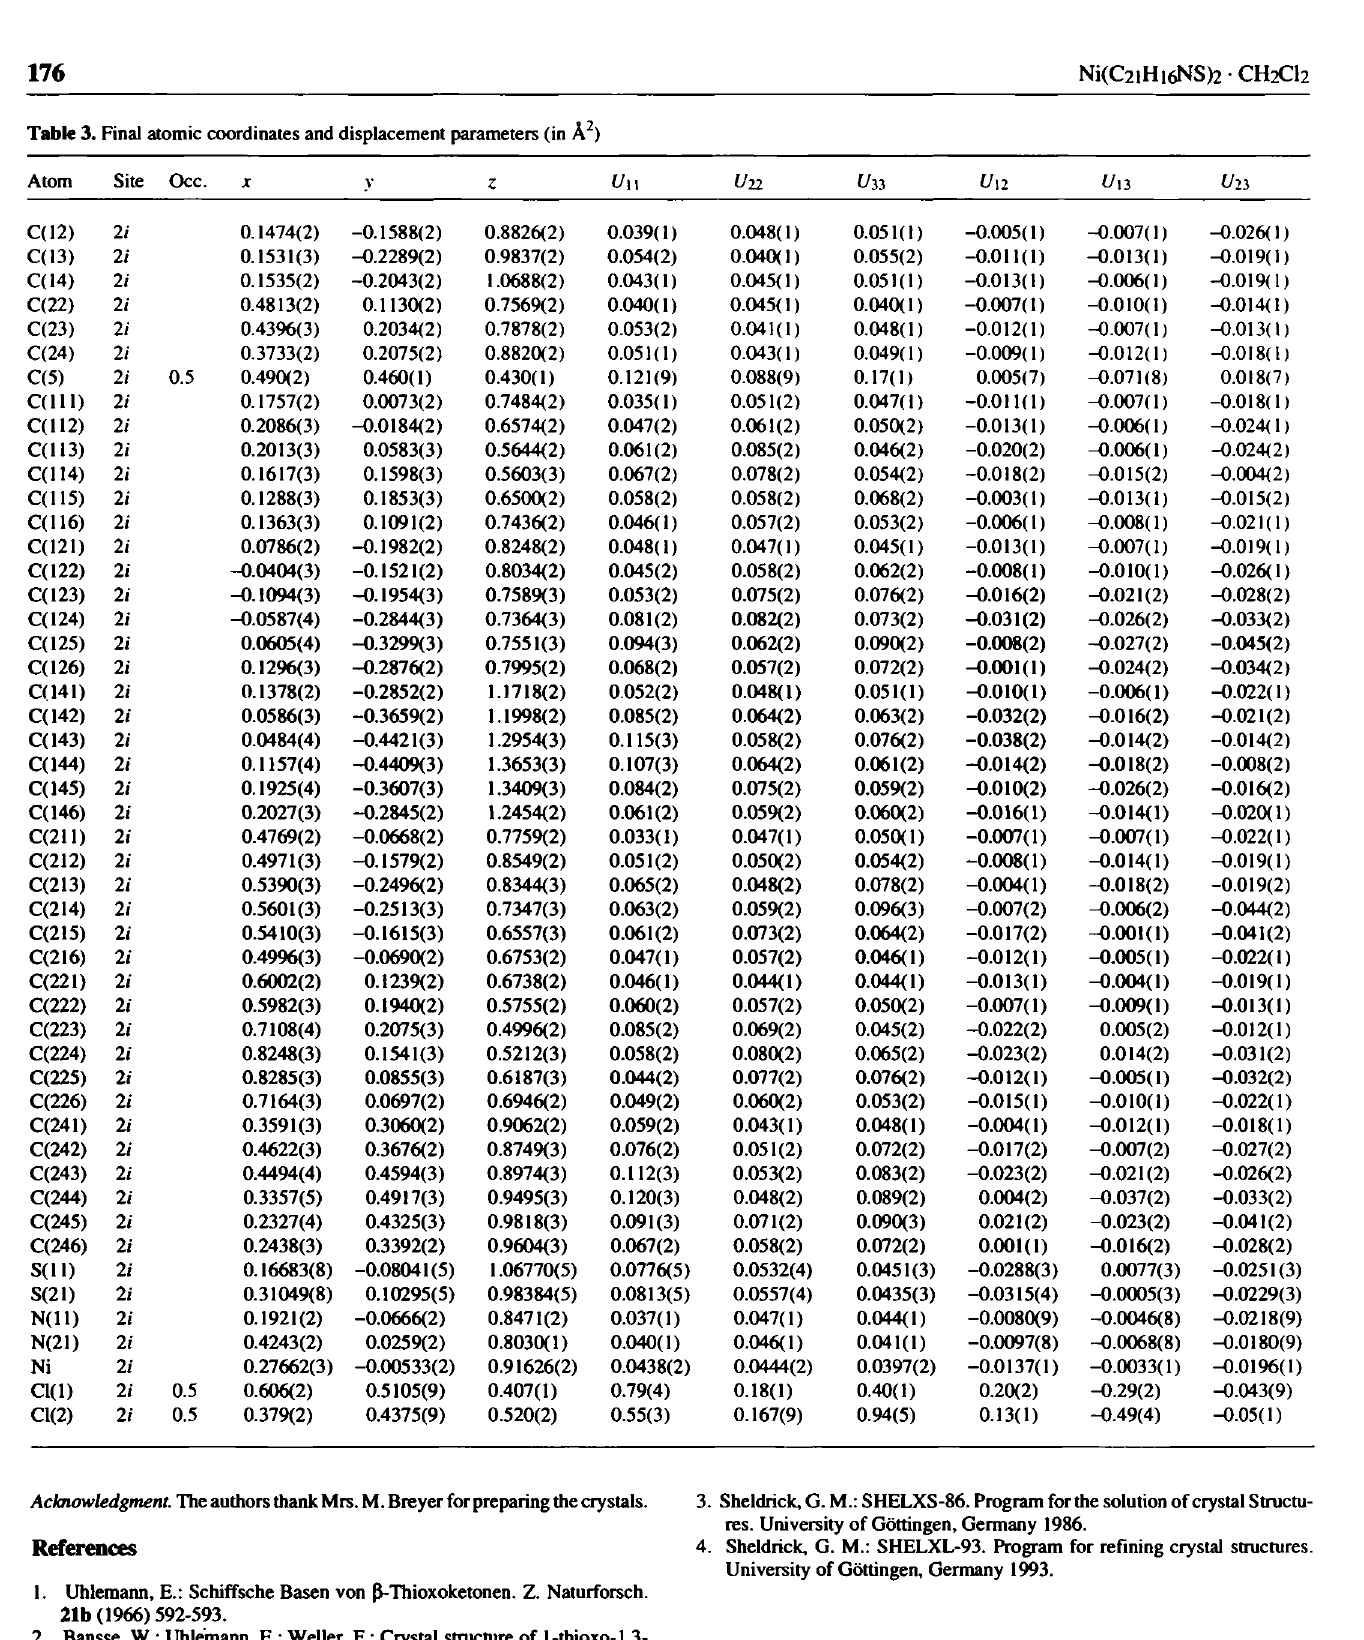
Tabic 3. Final atomic coordinates and displacement parameters (in